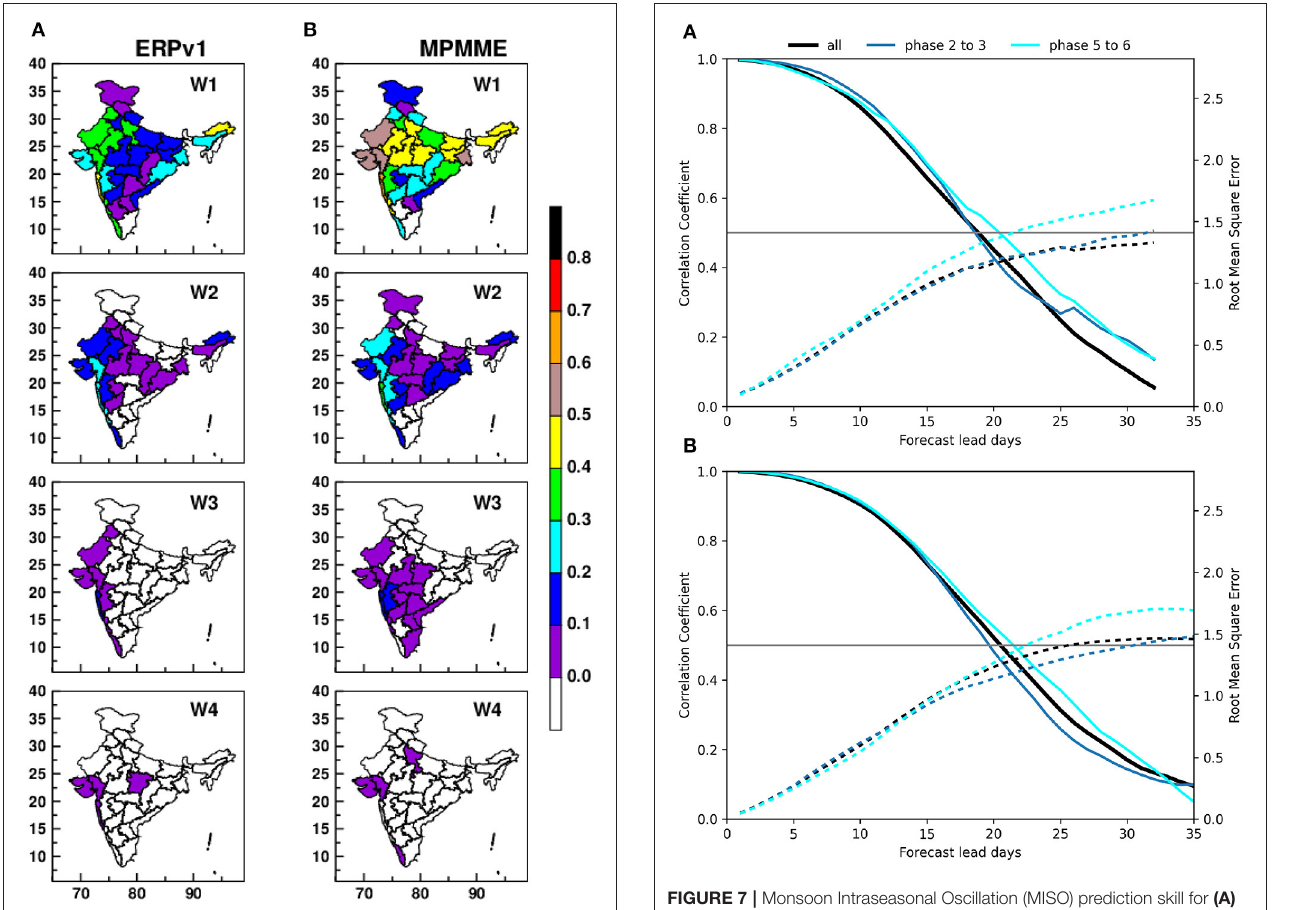
FIGURE 7 | Monsoon Intraseasonal Oscillation (MISO) prediction skill for (A) extended range prediction system (ERPv1) and (B) multi-physics multi-model ensemble (MPMME), where solid lines are for bivariate anomaly correlation coefficient (BVCC) and dotted line represent root mean square error